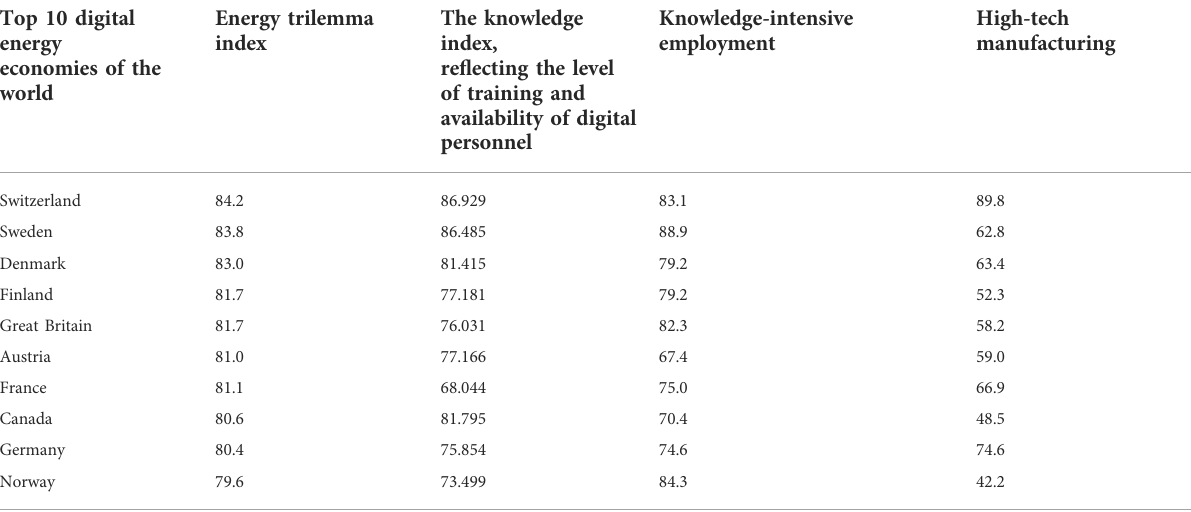
TABLE 1 Advanced HRM practices, digital personnel, high technologies of Industry 4.0 and energy sustainability in the top 10 digital energy economies of the world in 2021, score 0 –